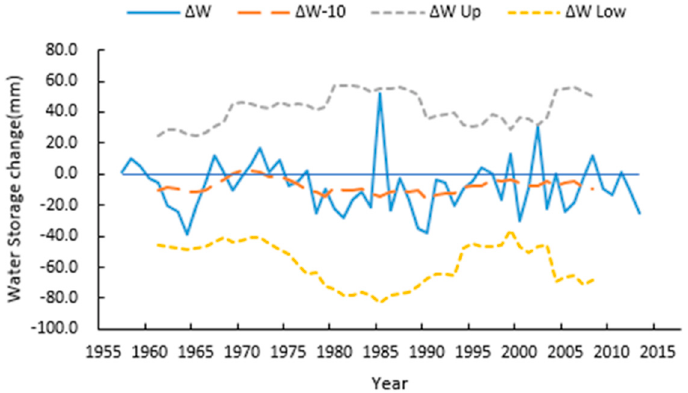
Figure 5. Annual time series for water storage change in SRYR; Annual time series of Δ W , 10 ‐ year moving average as Δ W ‐ 10, upper and lower uncertainty boundaries as Δ W Up/Low.